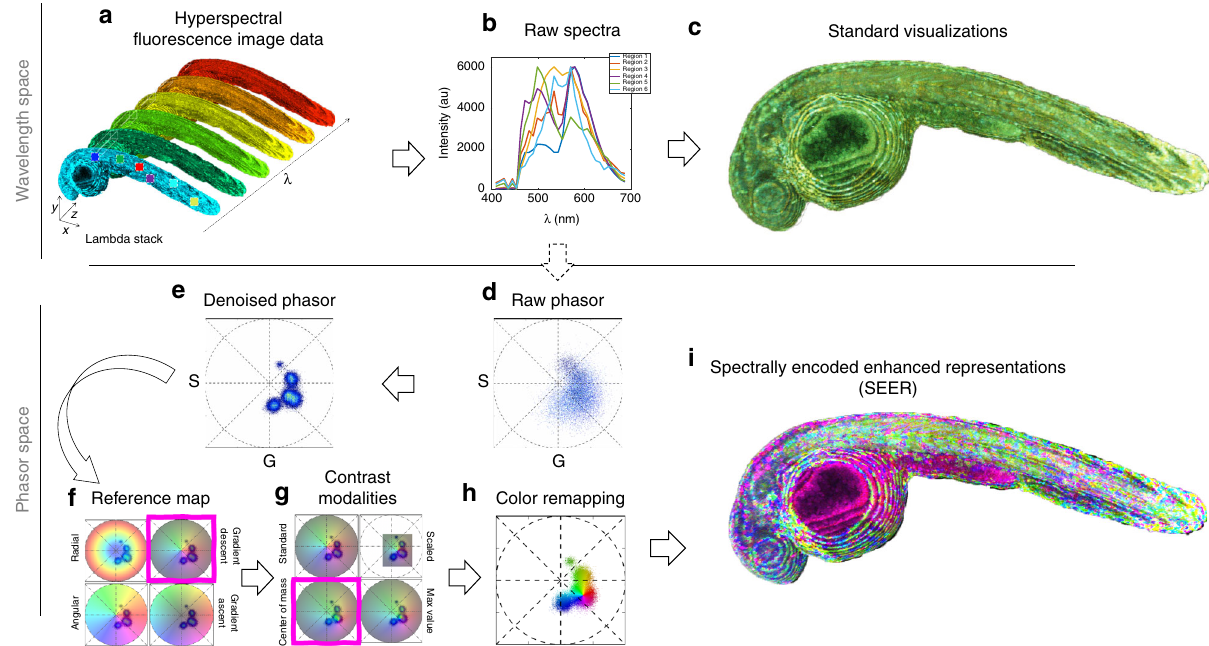
Fig. 1 Spectrally Encoded Enhanced Representations (SEER) conceptual representation. a A multispectral fl uorescent dataset is acquired using a confocal instrument in spectral mode (32 channels). Here we show a Tg(ubi:Zebrabow) 34 dataset where cells contain a stochastic combination of cyan, yellow, and red fl uorescent proteins. b Average spectra within six regions of interest (colored boxes in a ) show the level of overlap resulting in the sample. c Standard multispectral visualization approaches have limited contrast for spectrally similar fl uorescence. d Spectra for each voxel within the dataset are represented as a two-dimensional histogram of their Sine and Cosine Fourier coef fi cients S and G, known as the phasor plot. e Spatially lossless spectral denoising is performed in phasor space to improve signal 29 . f SEER provides a choice of several color reference maps that encode positions on the phasor into predetermined color palettes. The reference map used here (magenta selection) is designed to enhance smaller spectral differences in the dataset. g Multiple contrast modalities allow for improved visualization of data based on the phasor spectra distribution, focusing the reference map on the most frequent spectrum, on the statistical spectral center of mass of the data (magenta selection), or scaling the map to the distribution. h Color is assigned to the image utilizing the chosen SEER reference map and contrast modality. i Nearly indistinguishable spectra are depicted with improved contrast, while more separated spectra are still rendered